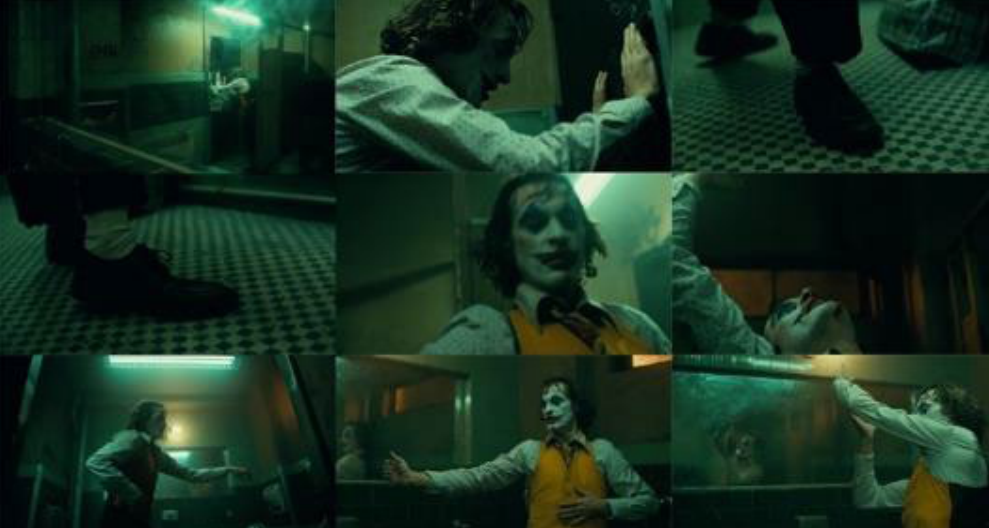
Figure 31 Composition of shots from the Metamorphosis scene in